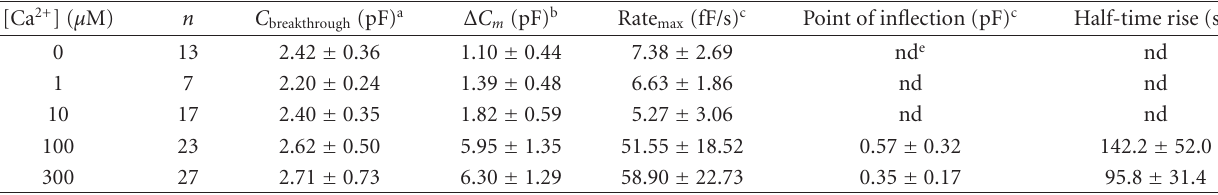
Table 1: Basic characteristics of the secretory process in human